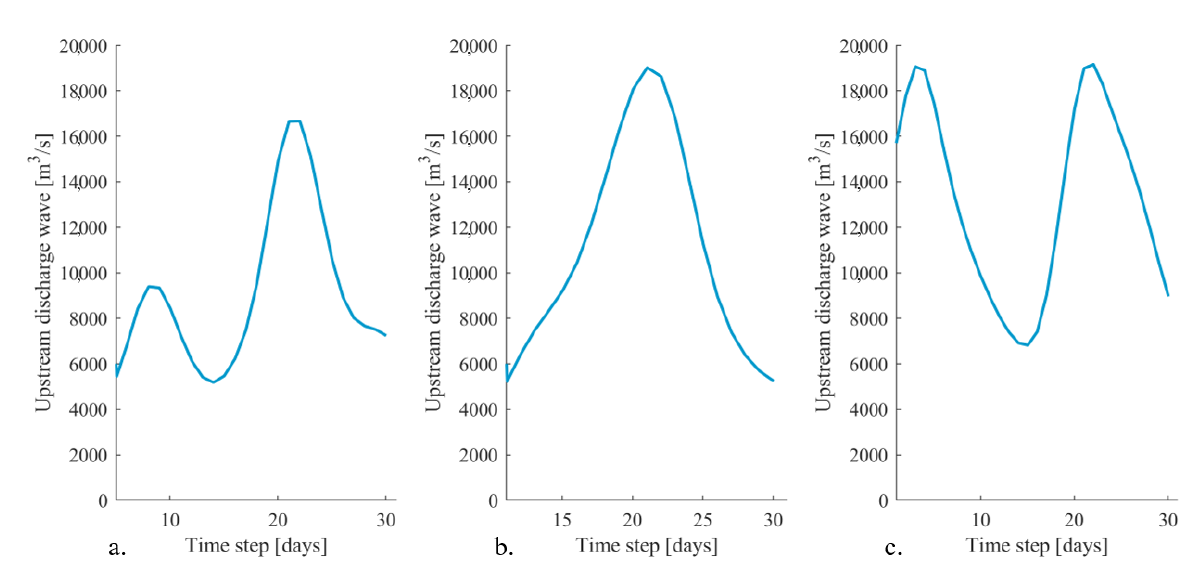
Figure 8. ( a – c ) The three upstream discharge waves used to verify the suitability of the NARX networks to predict outflow hydrographs of potential dike